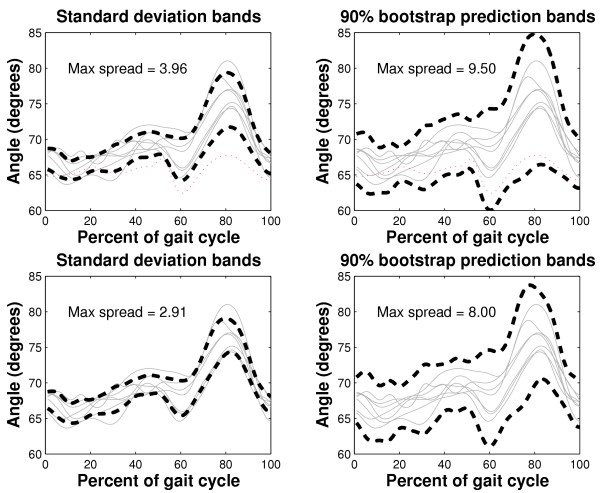
Estimation of spread in a group of registered knee angle curves from a 13-year old child with spastic diplegia. The left column depicts the standard deviation bands with (top graph) and without (bottom graph) an apparent outlying curve (thin dashed line). The 90% bootstrap prediction bands are plotted on the right, again with (top graph) and without (bottom graph) the outlying curve.